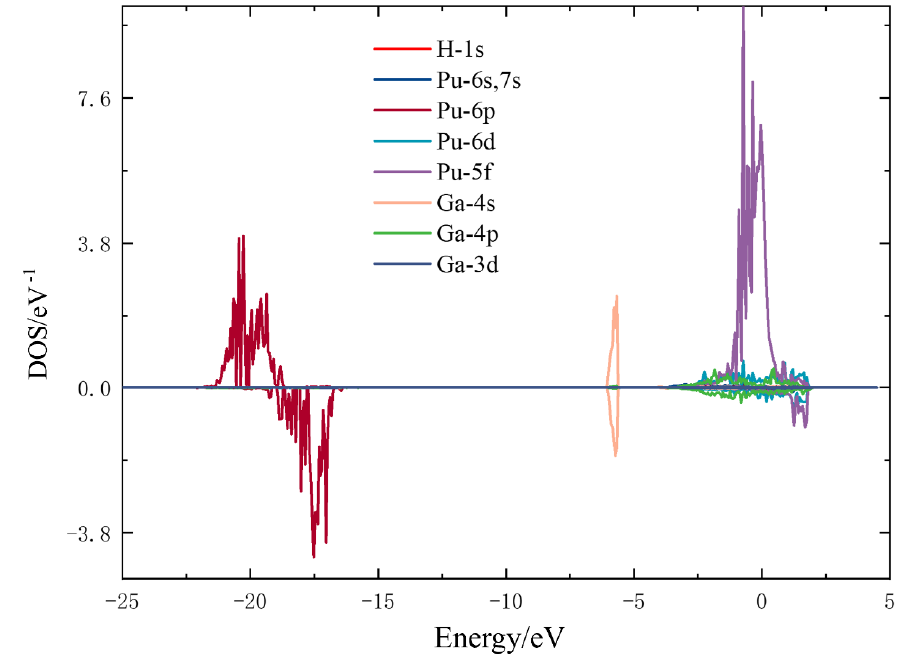
Figure 5. Fractional wave density of states for the H-h-hor1 configuration.